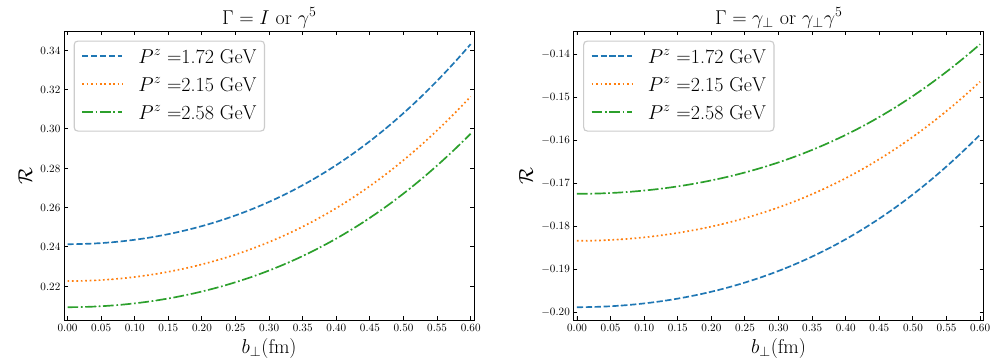
Figure 12 . Similar with figure 11 but using a phenomenological model for quasi-TMDWFs in eq.